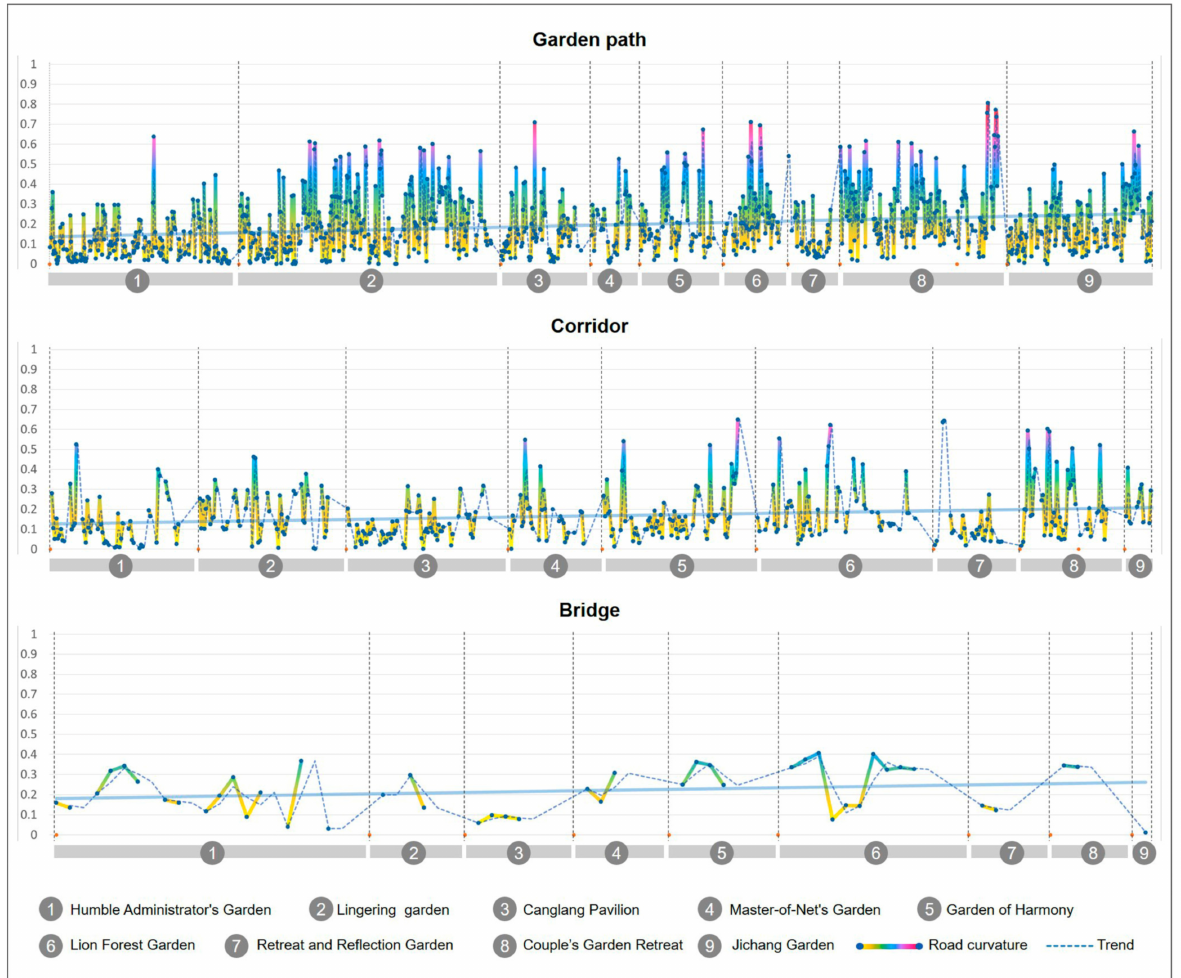
Figure 5. Road curvature analysis map of nine typical